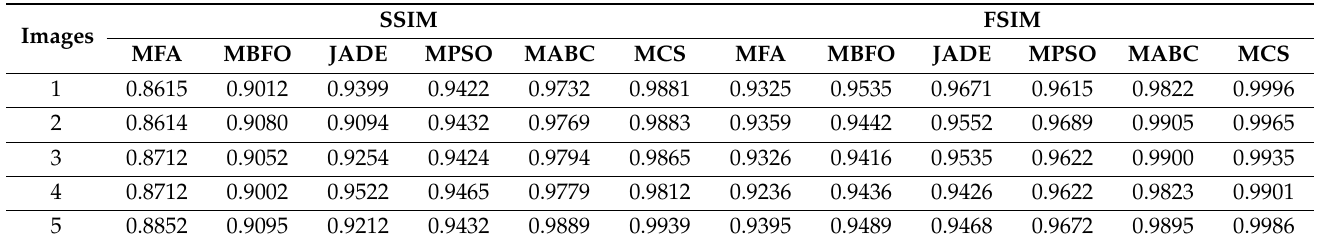
Table 11. SSIM and FSIM computed by different algorithms using R é nyi’s entropy.